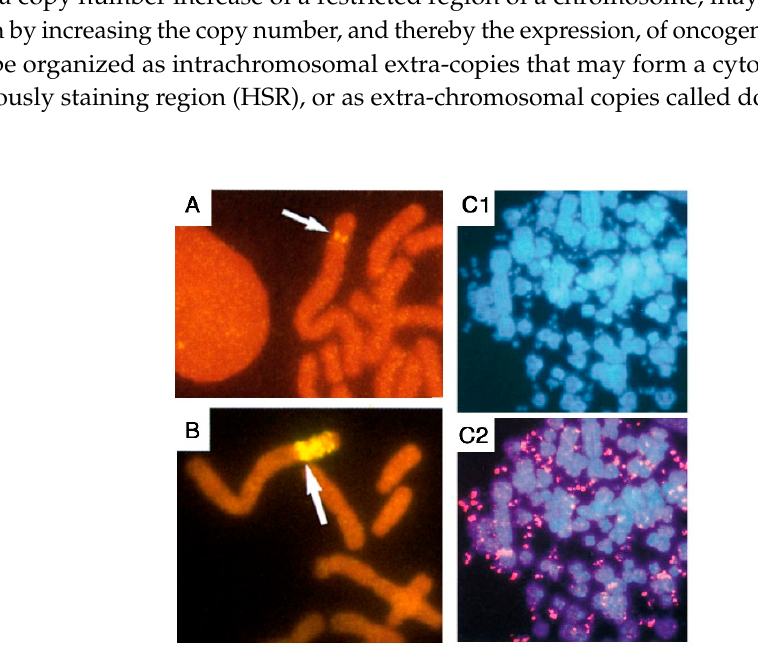
Figure 1. Gene amplification in mammalian cells can be intra- or extra-chromosomal. Fluorescent in situ hybridization (FISH) with a probe specific to the AMPD2 gene was performed in cells either unamplified ( A ) or exhibiting intra- ( B ) or extra-chromosomal ( C ) AMPD2 gene amplification. Partial metaphases are shown. In ( A , B ), a biotinylated probe was hybridized to chromosomes stained in red with propidium iodide, and the AMPD2 genes (arrows) were detected with avidin and anti-avidin antibodies coupled with FITC (yellow fluorescence). In ( C ), a digoxigenin-labelled probe was hybridized to chromosomes and DMs stained in blue with DAPI ( C1 ), and the AMPD2 genes were detected ( C2 ) with antibodies against digoxigenin coupled with TRITC (red fluorescence). Adapted from refs. [6,7].